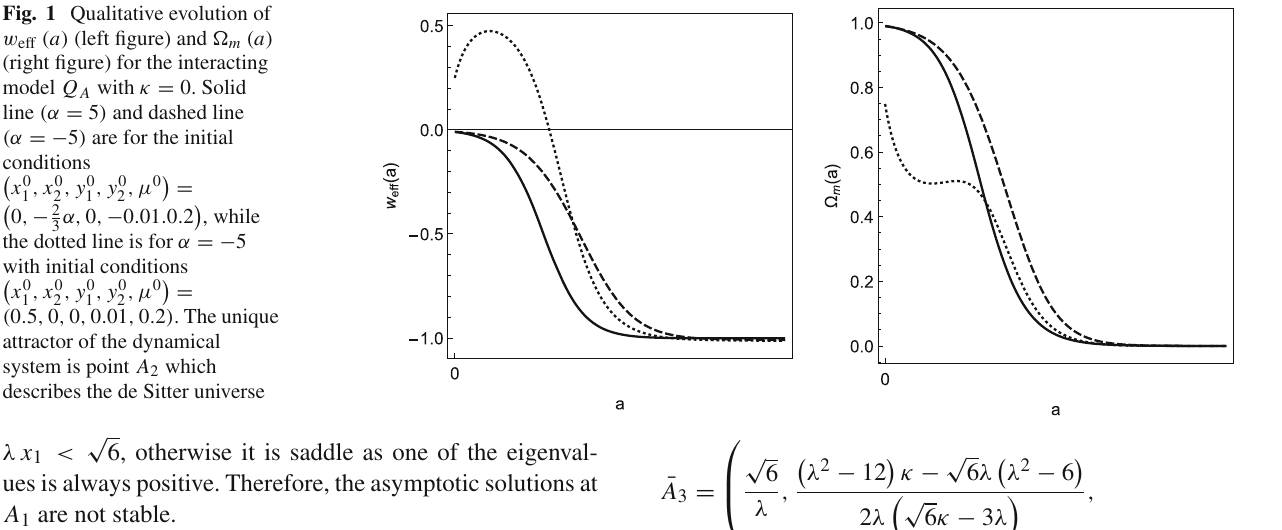
Fig. 1 Qualitative evolution of w ( a ) (left figure) and (cid:18) ( a ) m eff (right figure) for the interacting model Q A with κ = 0. Solid line (α = 5 ) and dashed line (α = − 5 ) are for the initial conditions (cid:2) (cid:3) , x 0 , y 0 , y 0 ,μ 0 = x 0 (cid:2) (cid:3) 1 2 1 2 α, 0 , − 0 . 01 . 0 . 2 0 , − 2 , while 3 the dotted line is for α = −